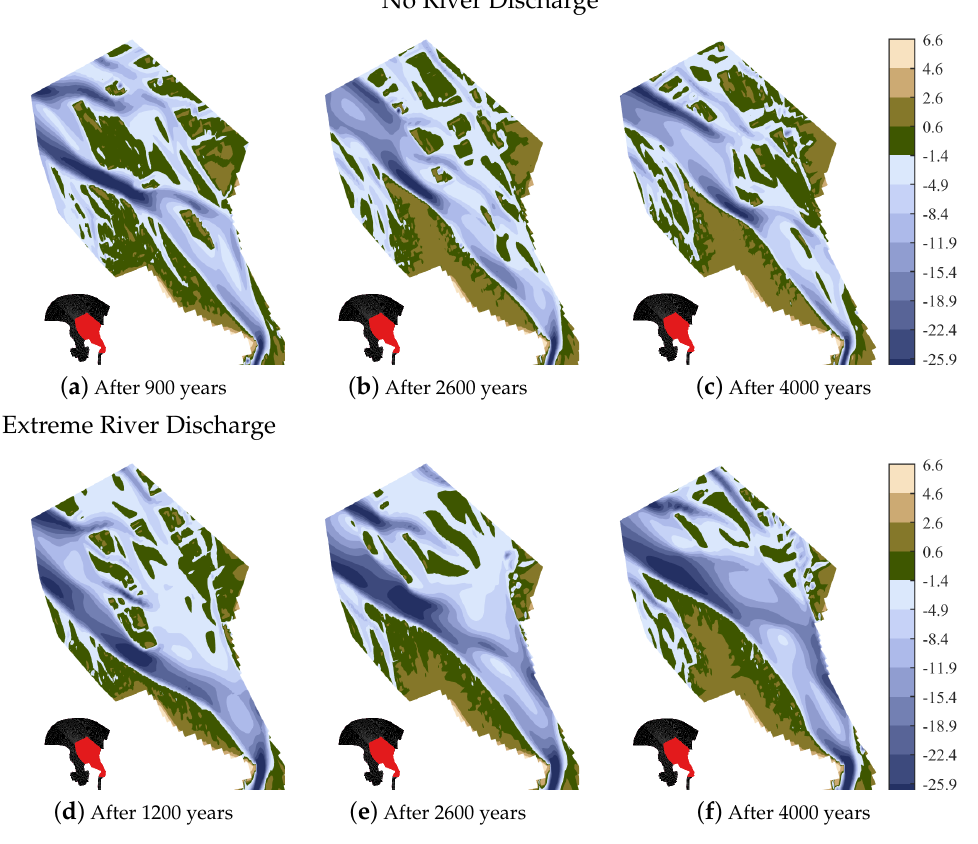
Figure A2. Results of the river discharge scenario simulations at three different times in years (hydrodynamic time multiplied with the morphological factor). The first shown time-step is selected based on equilibrium conditions. Clear distinction between the channel (blue colors) and shoal (earth colors)